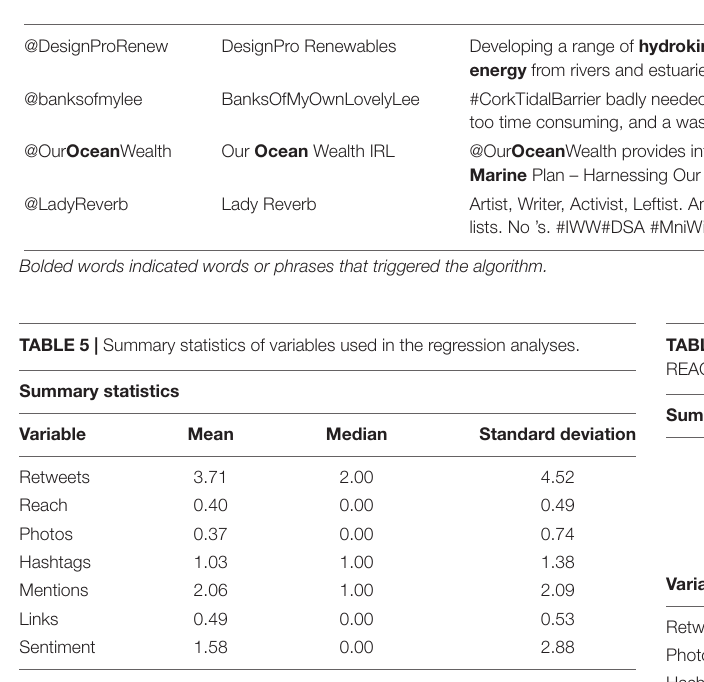
TABLE 4 | Examples of the users and the classification scheme.